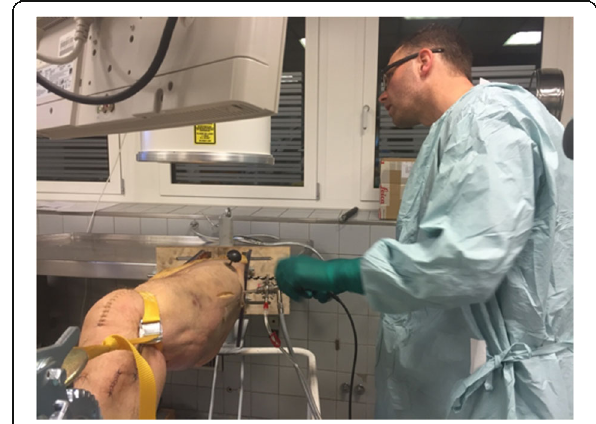
Fig. 4 Images of the surgical setup during ACH. The lateral portal was placed using fluoroscopic